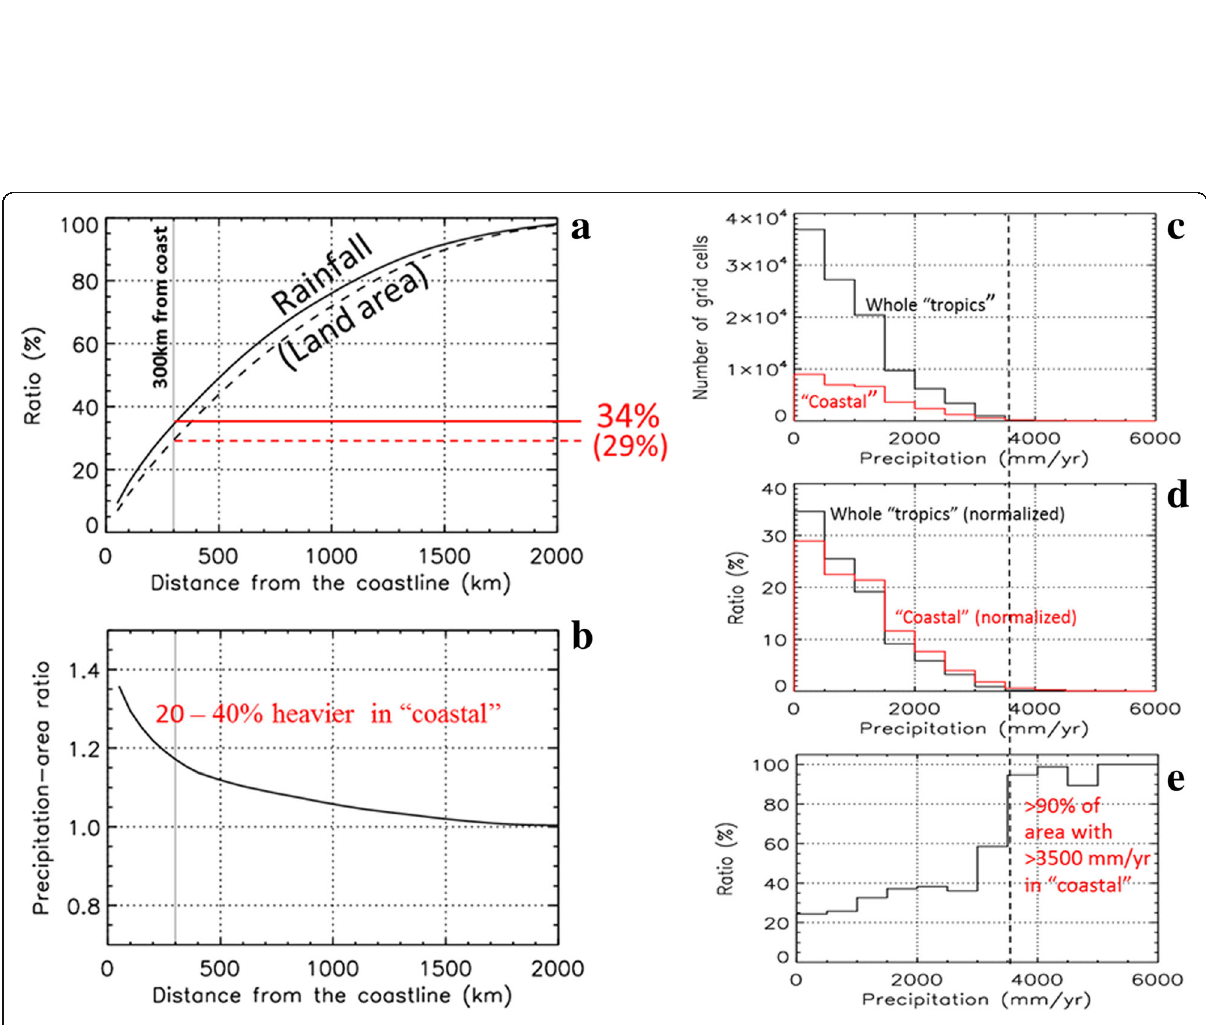
Fig. 13 a Share of rainfall observed by TRMM − PR (latitude < 37°; December 1997 – January 2011) and land area and b rainfall “ heaviness ” relative to the whole tropical mean, as functions of the coastal distance. c Histogram of grid cell numbers and d the normalized histogram, and e histogram of coastal share, all as functions of rainfall intensity. After Ogino et al. (2016)